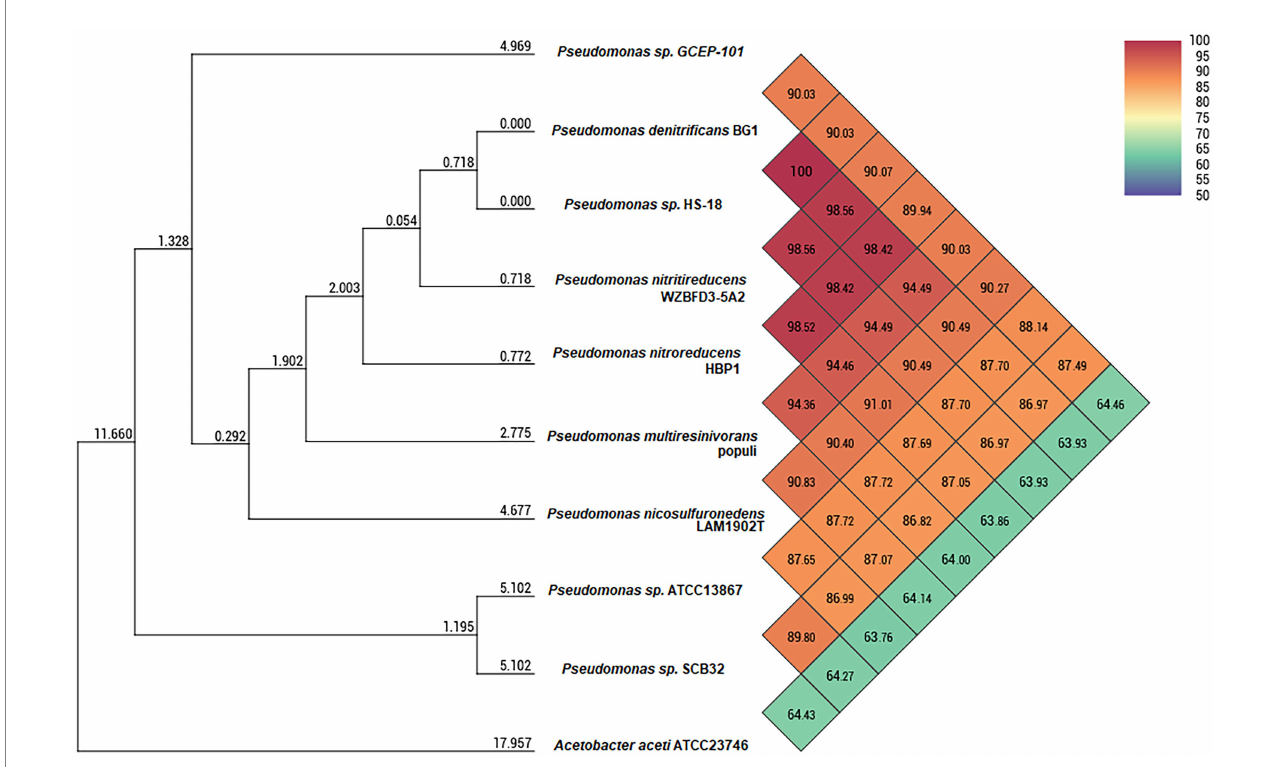
FIGURE 3 Heatmap of Orthologous Average Nucleotide Identity (OrthoANI) between strain GCEP-101 and closely related relatives. Values in color scale indicate the similarity percentage among the genomes. The numerical values on the branches represent the calculated intergenomic genetic distance calculated by the Orthologous Average Nucleotide Identity Tool (OAT)